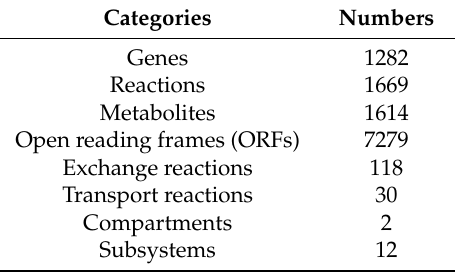
Table 2. Composition of Genome-Scale Metabolic Models (GSMM) Aspm1282 for Actinosynnema pretiosum ATCC